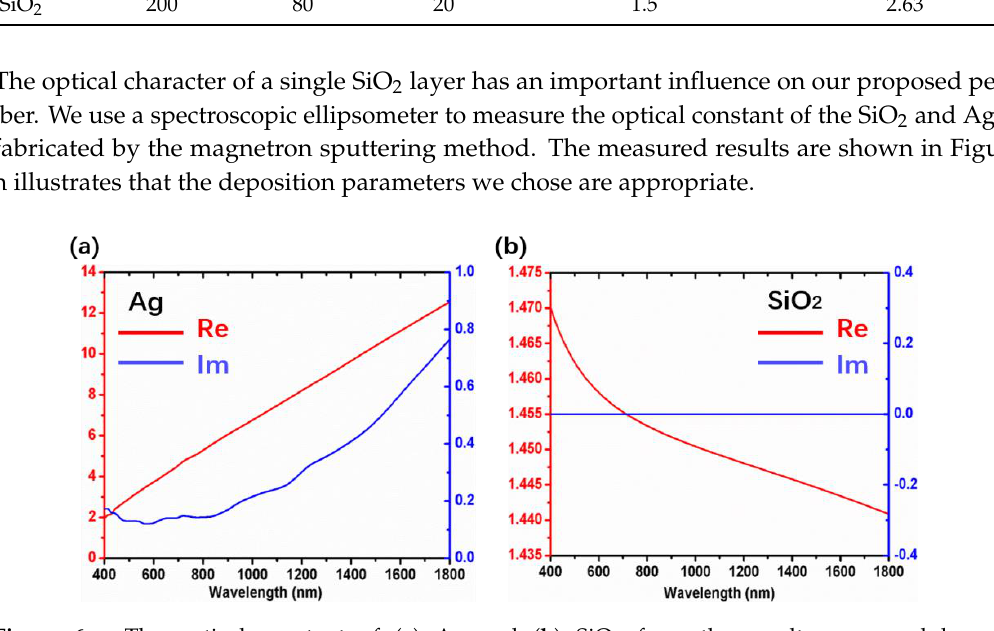
Figure 6. The optical constant of ( a ) Ag and ( b ) SiO 2 from the results measured by a spectroscopic ellipsometer.